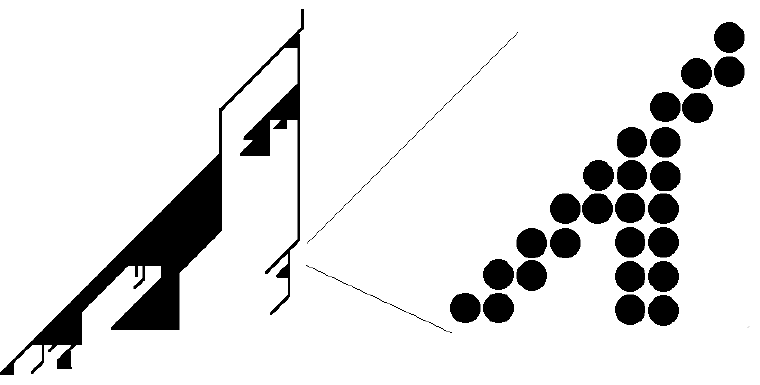
Figure 11. Standard example of a chinampa. ( left ) Zoomed-out image of a chinampa, where the chinampa can be represented by stacking pyramids. ( right ) Zoomed-in image of a chinampa, where we see the details of the activation diagram. The lines in the left figure are groups of activated vertices.